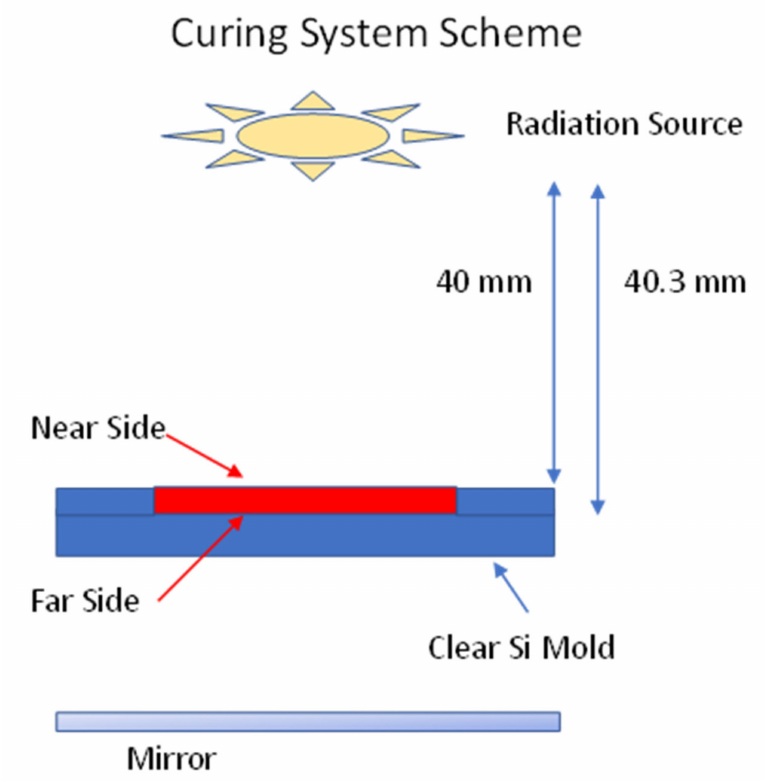
Figure 3. Schematic illustration of the curing